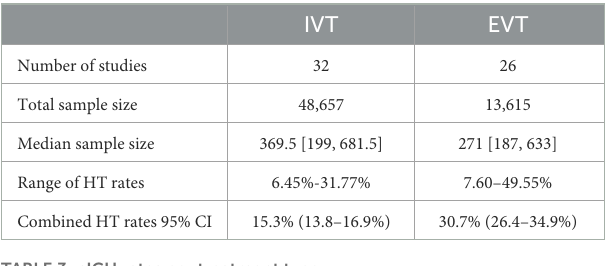
TABLE 3 sICH rates per treatment